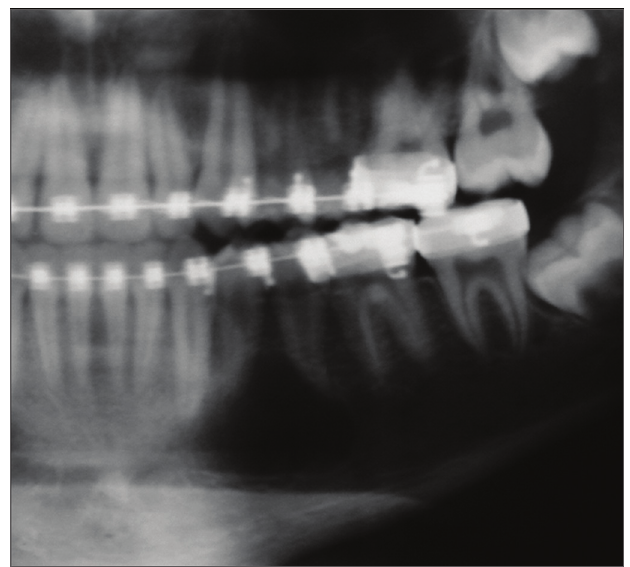
Figura 2. Radiografia panorâmica mostrando uma lesão radiolúcida unilocular no corpo mandibular esquerdo. A radiotransparência exibe o festonamento clássico em volta dos ápices dos